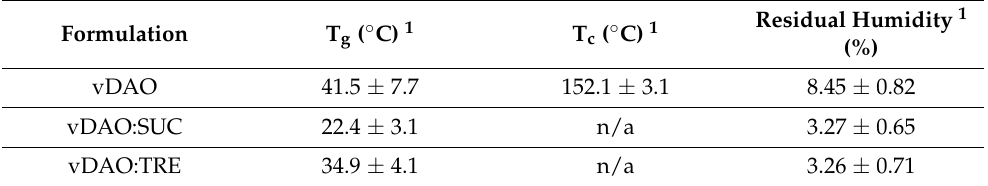
Table 1. Thermal properties of vDAO lyophilized in the absence or the presence of